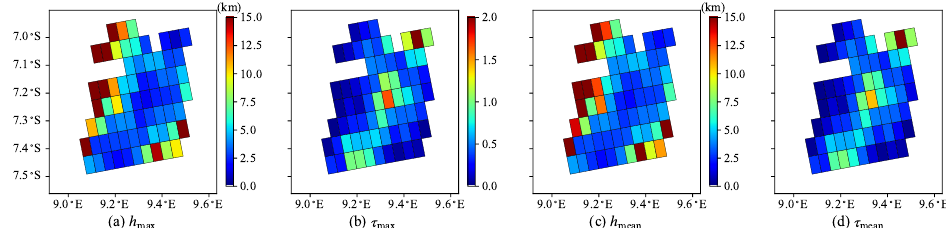
Figure 17. The same as in Figure 15 but for the data on 5 July 2019.